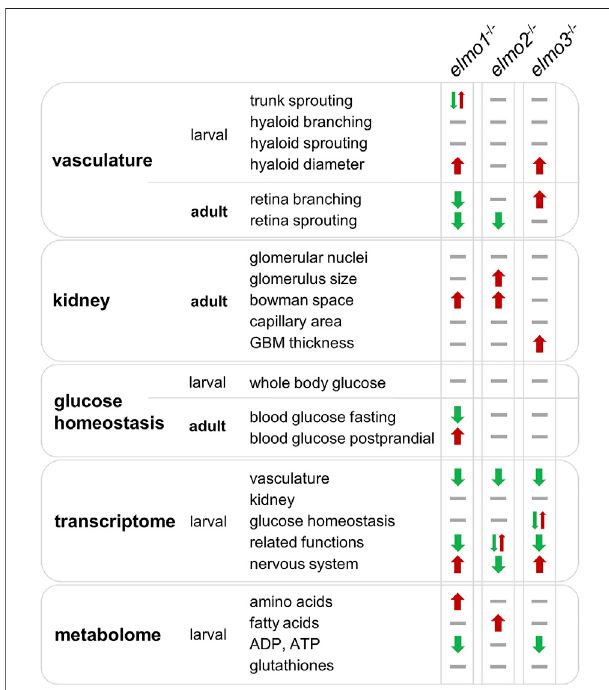
FIGURE8| Comparison of elmo1 − / − , elmo2 − / − and elmo3 − / − phenotype inzebra fi shindicatesdifferentfunctionsofElmo1,Elmo2andElmo3.Overview and comparison of the results of the phenotypical analysis of elmo1 − / − , elmo2 − / − and elmo3 − / − zebra fi sh in larval and adult stages indicate that Elmo1, Elmo2 and Elmo3 have not the same role in the regulation of the organism. Listed are all fi elds which were analyzed in this study and their outcome in the speci fi c zebra fi sh line. Results are visualized with arrows and bars. Arrow up (red) indicates an increase, arrow down (green) indicates a decrease, one arrow up and one arrow down at once indicate different changes, bar (grey) indicates no change. GBM, glomerular basement